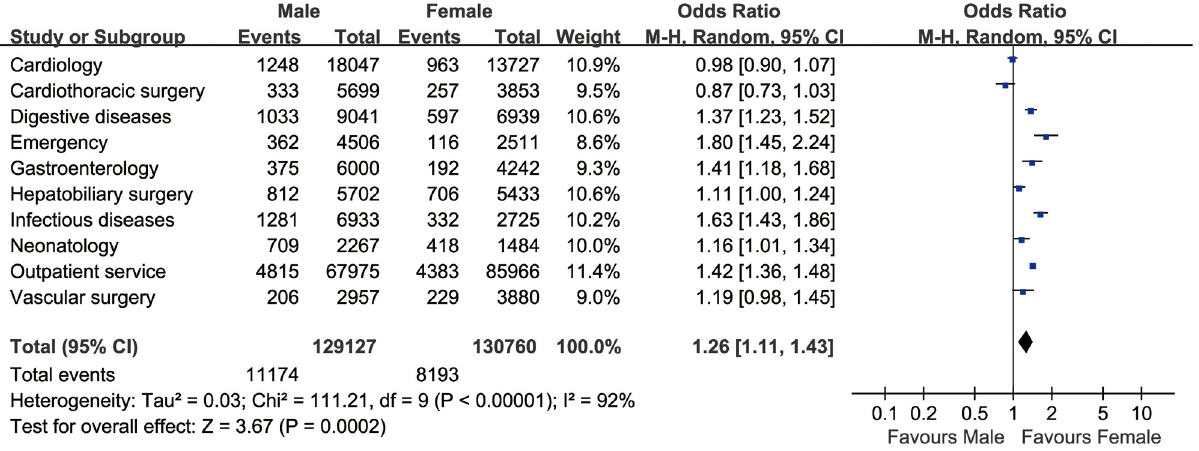
Fig 3. The pooled OR based on the top ten high icterus incidence departments (n = 259,887).